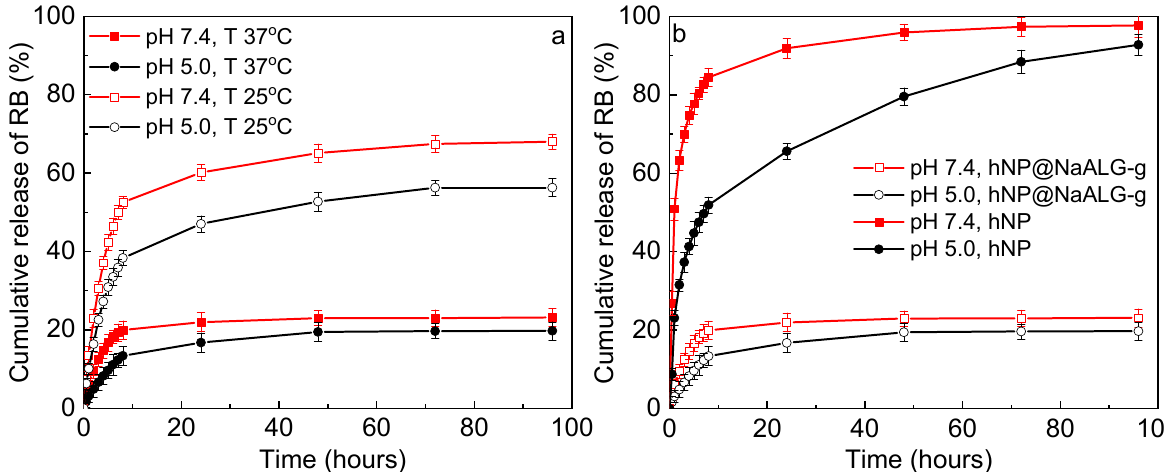
Figure 9. ( a ) Release of RB at different pH and temperatures from the composite hNP@NaALG-g formulation for a 5% wt NaALG-g hydrogel. ( b ) For the sake of comparison, the data of the RB release, at pH 5.0, pH 7.4 and at 37 °C, from the hNP particles (single bilayer: SiO 2 @PAH/NaALG-g, from Figure 8a) and the hNP@NaALG-g composite hydrogel (from Figure 9a) are also presented. Each point is the mean of three independent measurements, and bars represent standard deviation of means.